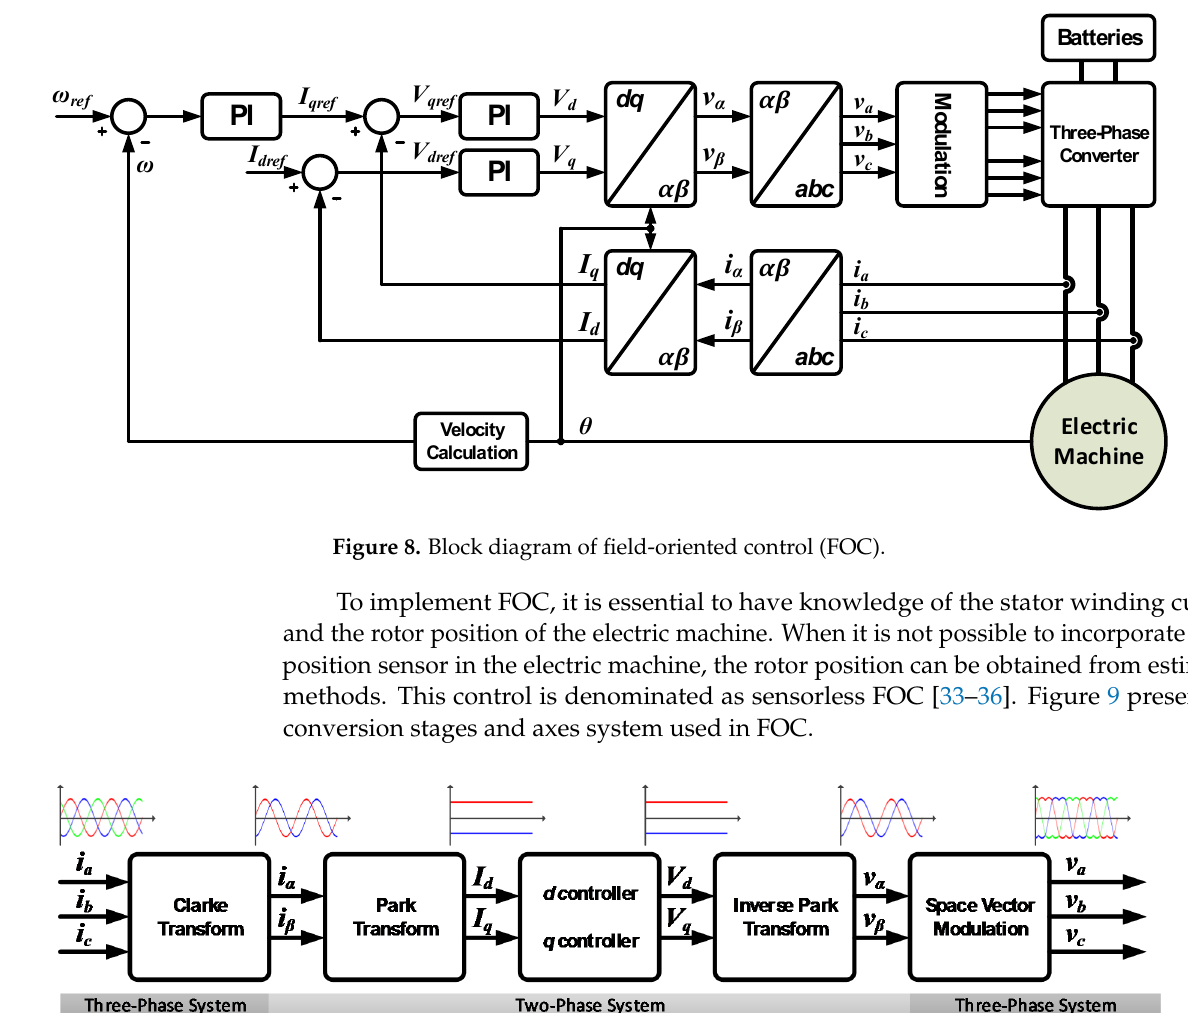
The three electric machine currents ( i a , i b , and i c ) are converted into a two-dimensional